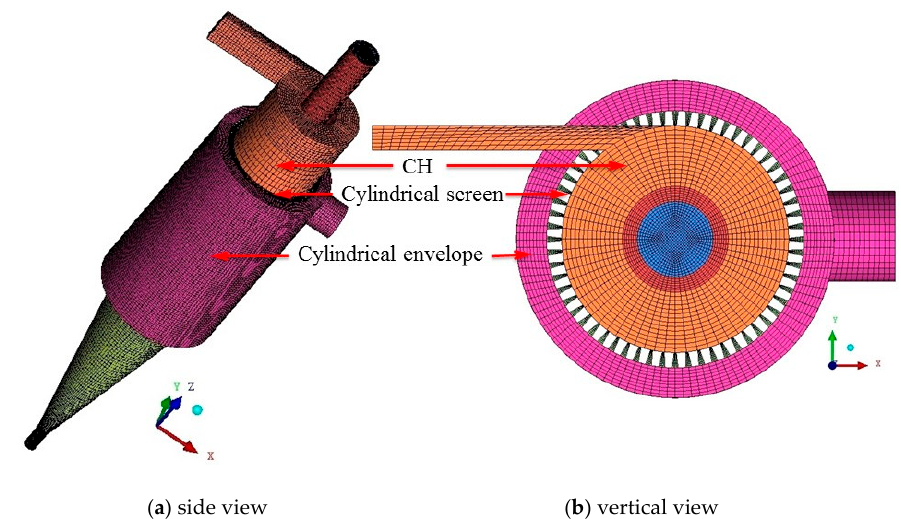
Figure 3. Mesh profile of TPHS: ( a ) side view, ( b ) vertical view.